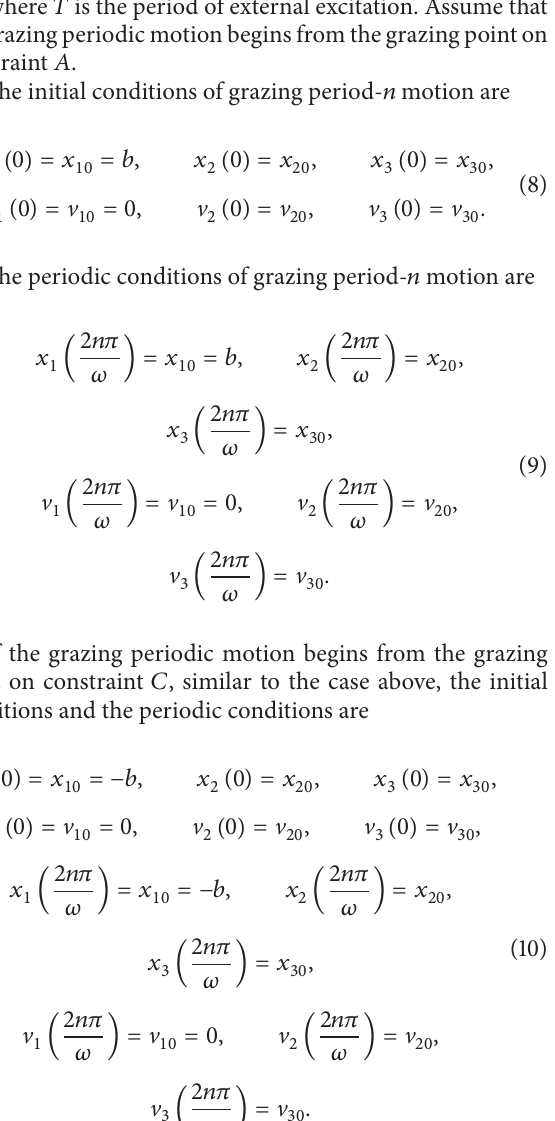
The nondimensional quantities 𝑚 𝑖 = 𝑀 𝑖 /𝑀 1 , 𝑘 𝑖 = 𝐾 𝑖 /𝐾 1 , 𝑓 = 𝑃 /𝐹 𝑡 = 𝑇√𝐾 /𝑀 𝜔 = Ω√𝑀 𝑖0 𝑖 0 , 1 1 , /2√𝐾 = 𝑋 𝐾 /𝐹 𝜁 = 𝐶 𝑀 𝑥 𝑖 𝑖 1 0 , 𝑖 𝑖 1 1 , and introduced, where 𝑖 = 1, 2, 3